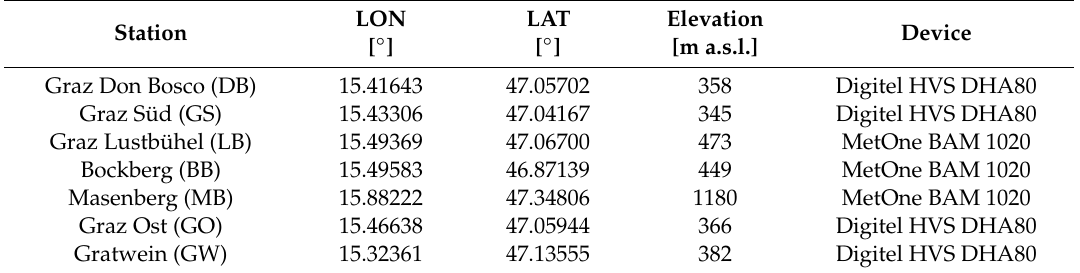
Table 1. Monitoring stations used in the present study. See locations in Figure